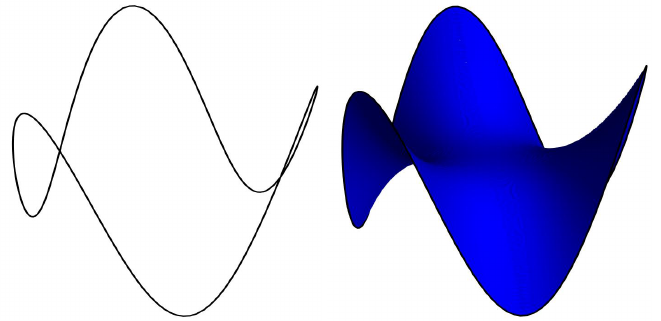
Figure 8. Extension of the function f ( x , y ) = x 3 − 3 xy 2 defined on D = { ( x , y ) ∈ R 2 : (cid:107) ( x , y ) (cid:107) = 2 } using the 2-average-slope-minimizing